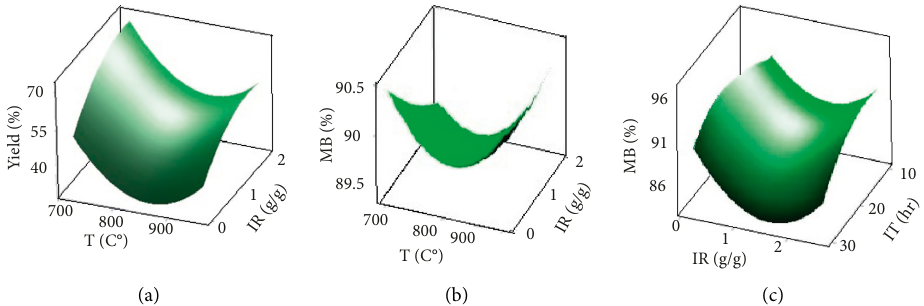
Figure 2: 3D plot of statistically significant interactions (the interaction effect of Tand IR on STAC yield (a); Tand IR on MB removal (b); and IR and IT on MB removal (c)).